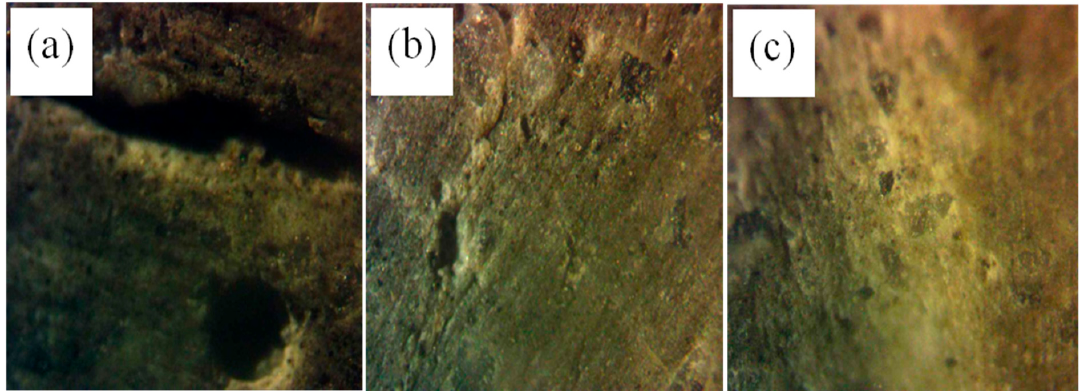
Figure 6. Optical images of cement of porcelain insulators ( a ) 50 years ( b ) 30 years ( c ) 10 years.